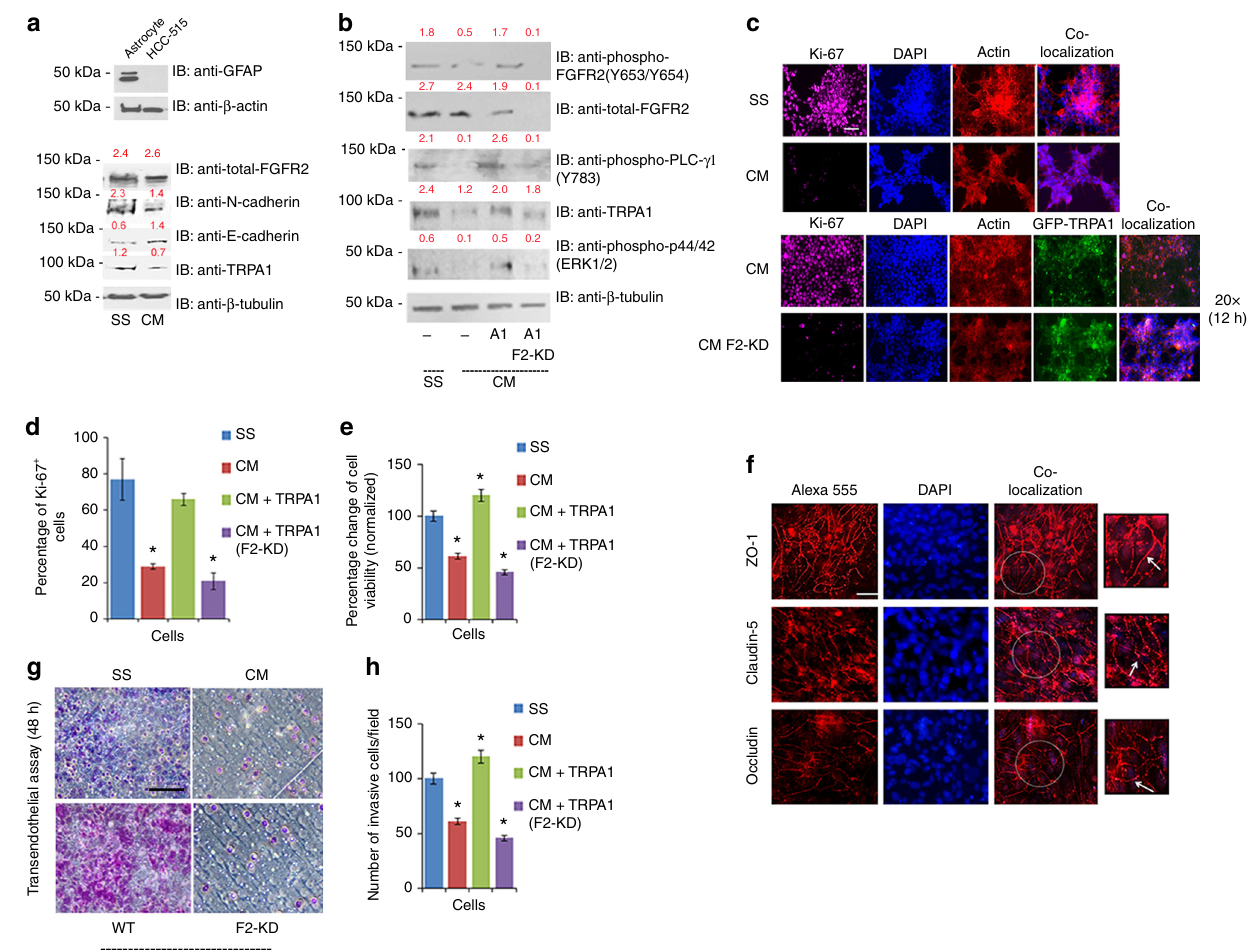
Fig. 5 Astrocytes decrease the proliferative and invasive potential of cancer cells by reducing TRPA1 expression level. a Upper panel: western blot analysis of GFAP expression level in astrocytes with HCC-515 cells used as a negative control. Bottom panel: western blot analysis of HCC-515 cells that have been serum starved (SS) or treated with conditioned media (CM). The blot was probed with the indicated antibodies. Normalized densitometric values are reported in red above each band throughout the fi gure and represent the average of three independent experiments. b Western blot analysis of HCC-515 cells without TRPA1 transfection ( − ), with TRPA1 transfection and scrambled shRNA (A1) or with TRPA1 transfection and FGFR2 knockdown (A1/F2_KD). In all cases, blots were probed with the indicated antibodies. c IF of HCC-515 cells stained with the proliferation marker, Ki-67. Scale bar: 50 μ m. d Bar graph quanti fi cation of ( c ), where the number of Ki-67 + cells were counted under the same magni fi cation in 6 random microscopic fi elds/sample and averaged. Error bars indicate s.d. ( n = 3 biological replicates). * P ≤ 0.05 by two-tailed Student ’ s t test. e Results of an MTT assay performed overnight and normalized against the values obtained for SS-treated-cells. Error bars indicate s.d. ( n = 3 biological replicates). * P ≤ 0.05 by two-tailed Student ’ s t test. f IF of tight junction proteins (ZO-1, Occludin and Claudin-5 depicted by white arrows in the zoom-in area) in RBE4 cells with different paracellular permeability that were grown in a trans-well chamber. TEER measurement of the integrity of the cellular barrier ranged in value between 150 and 200 ohm cm 2 . Scale bars: 20 μ m. g Representative images of a transendothelial assay with RBE4 monolayer from ( f ) utilized as a cellular barrier on top of which HCC-515 cells were incubated in SS media or CM media with 1% serum-supplemented media in the lower chamber. Images were taken at 20× magni fi cation. Scale bar: 100 μ m. h Quanti fi cation of the transendothelial assay results, where the number of invaded cells were counted in 8 different microscopic fi elds. Error bars indicate s.d. ( n = 3 biological replicates). * P ≤ 0.05 by two-tailed Student ’ s t